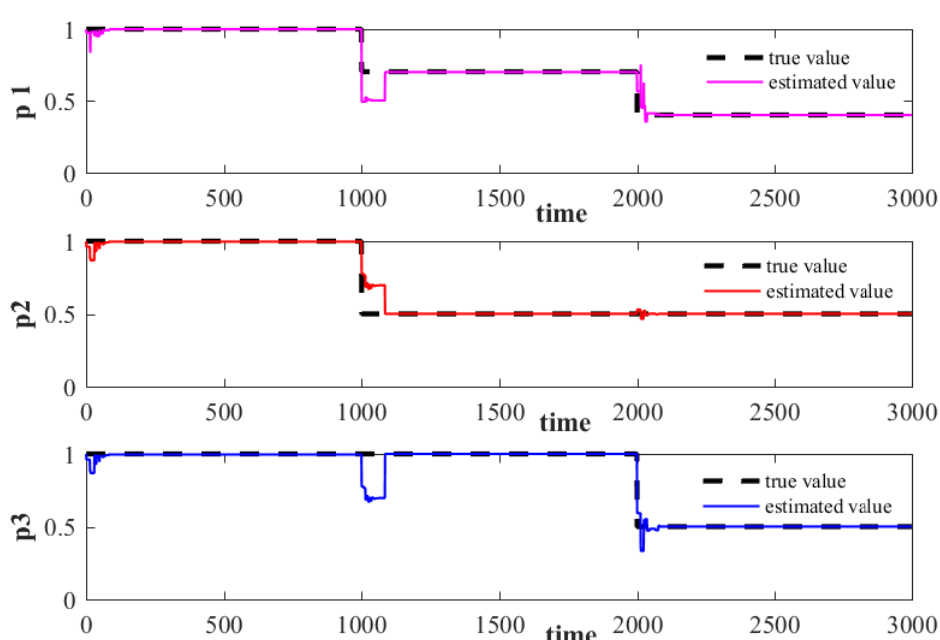
Figure 8. Correlation oefficient based parameters estimation (noise